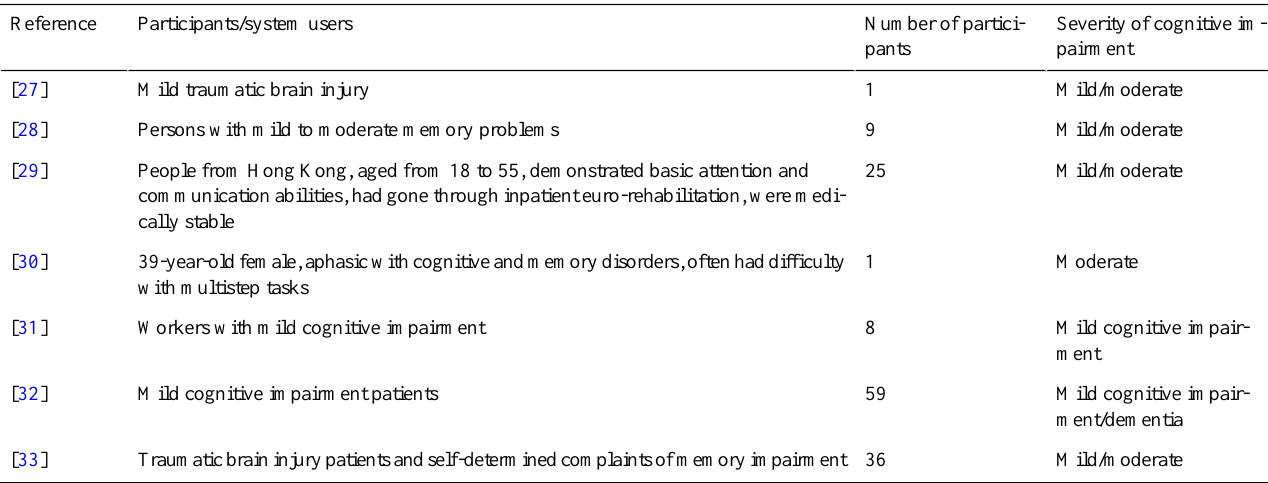
Table 4. Demographic information about study